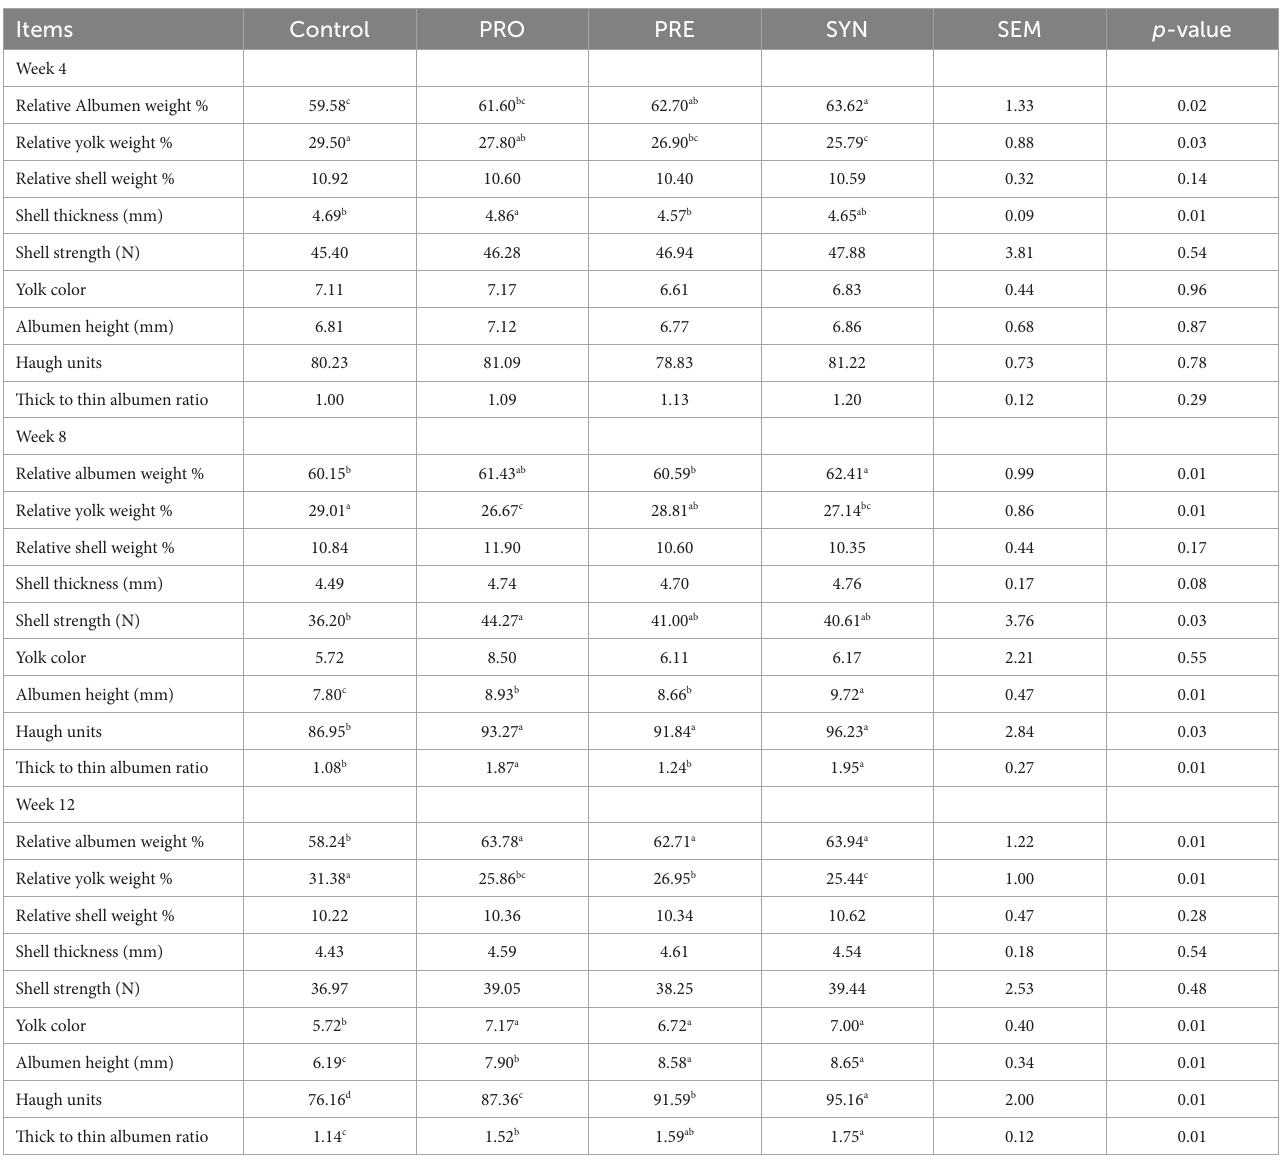
TABLE 3 Effects of dietary treatments on the egg quality of laying hens.